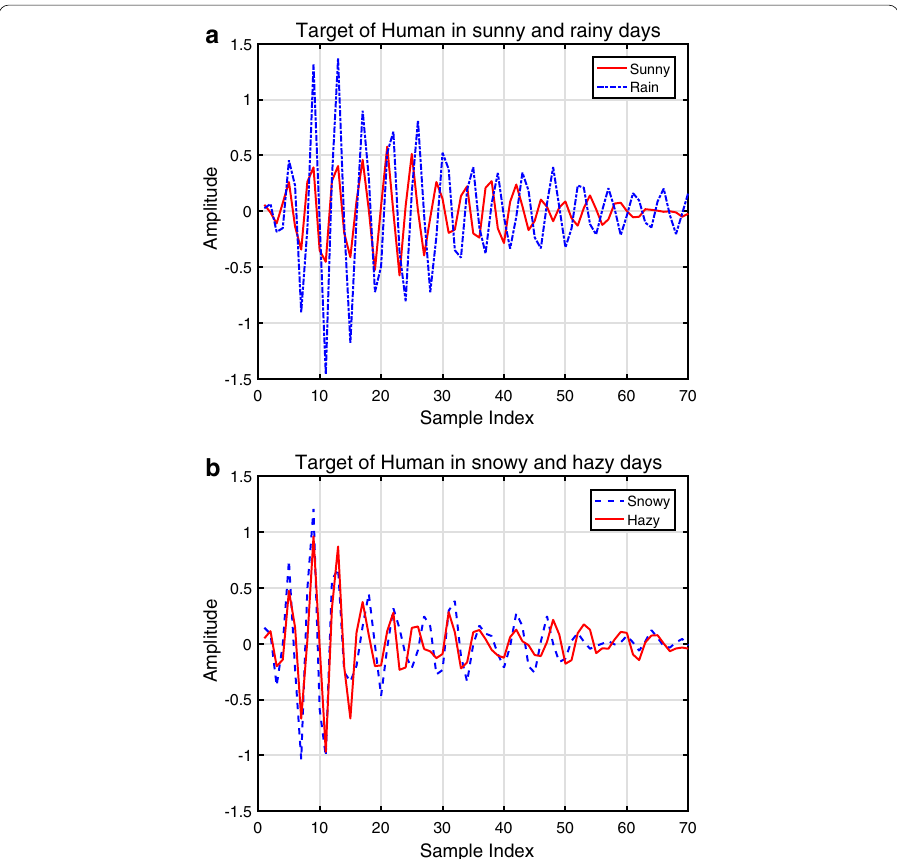
Fig. 5 Received UWB signals of human in different weather before